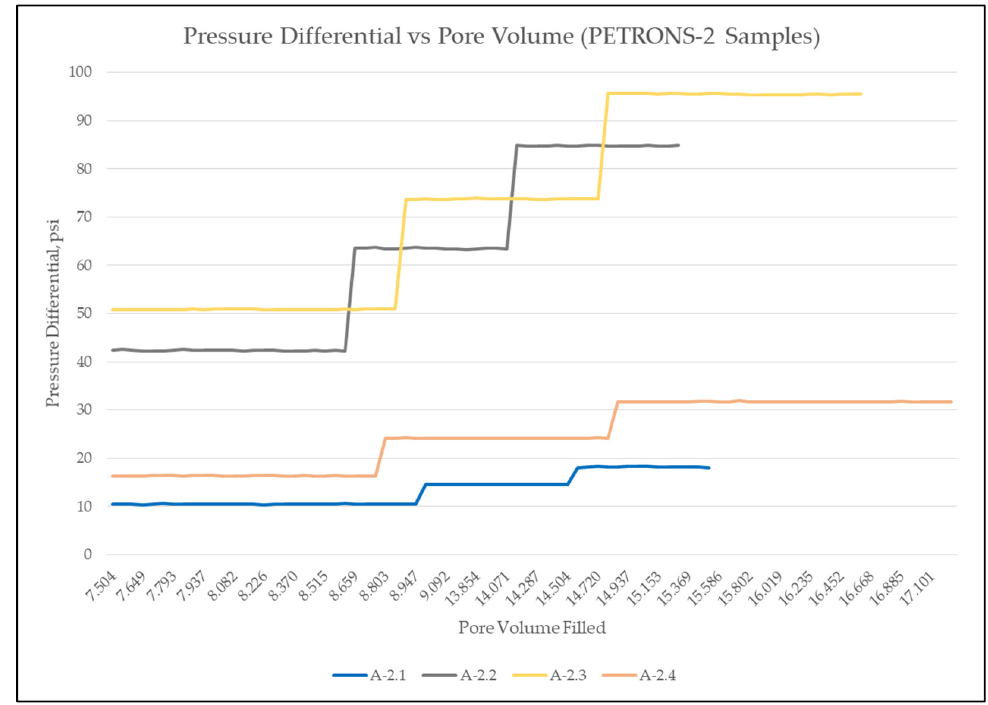
Figure 11. Graph of pressure differential against pore volume filled for PETRONS-2 samples. Water permeability values of the core samples were calculated using Darcy’s equa- tion as shown in Equation (2). Since brine was injected at three different flow rates for each sample, stable pressure differential values at each flow rate were recorded as shown